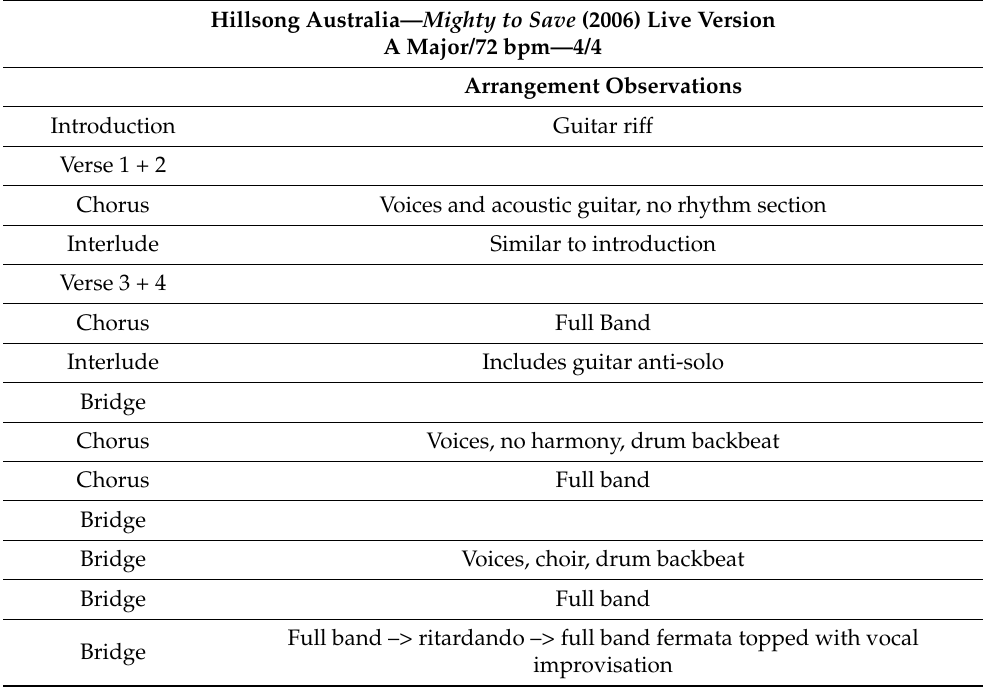
Table 2. Form and arrangement outline of “Mighty to Save” in its original